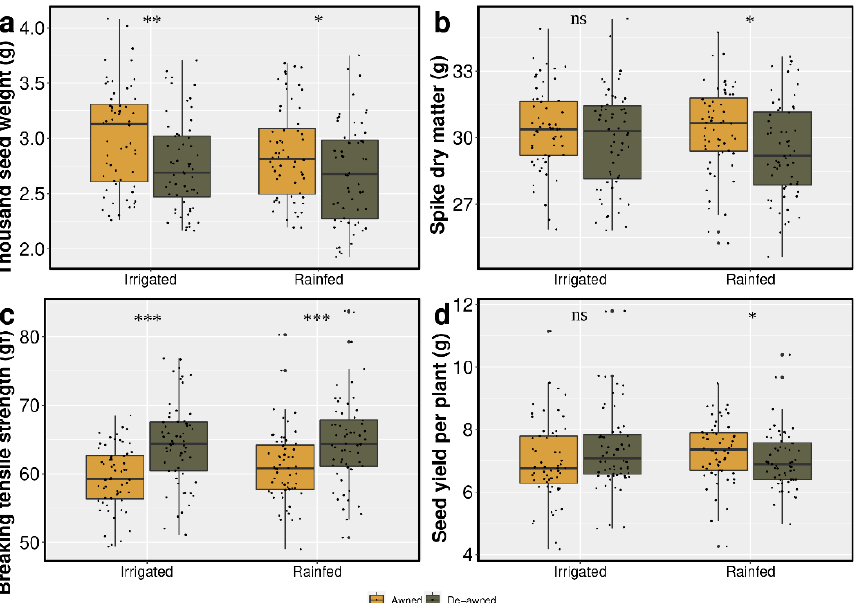
Figure 7. Box plots of thousand-seed weight ( a ), spike dry matter ( b ), breaking tensile strength ( c ), and yield per plant ( d ), and significance levels of difference between control and awn excision. ns: not significant, * p < 0.05, ** p < 0.01, *** p < 0.001. Each box plot denotes the average of 10 accessions for corresponding traits. The significances indicate the comprehensive effect of awn excision on different traits of 10 Siberian wildrye accessions.